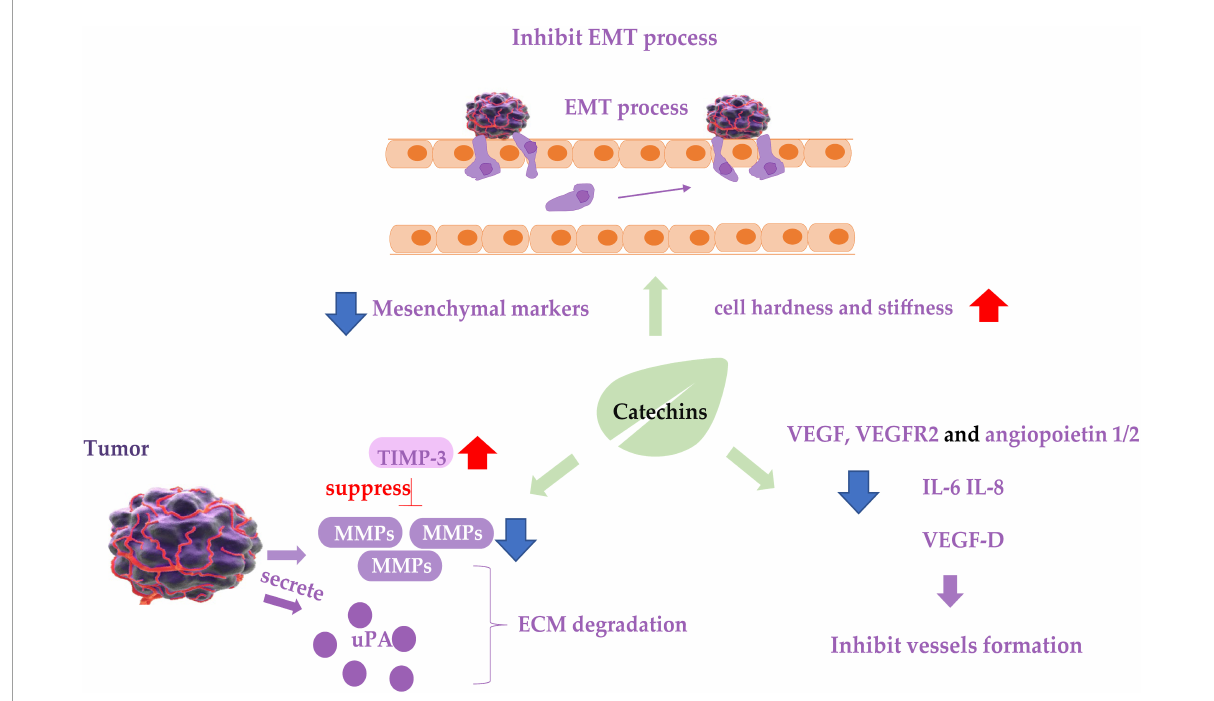
FIGURE2 Diagram of catechins inhibiting cancer cell metastasis. Blue arrows indicate downregulation and red arrows indicate upregulation. EMT, epithelial-mesenchymal transition process; TIMP-3, tissue inhibitor of metalloproteinase-3; MMP, matrix metalloproteinases; ECM, extracellular matrix; uPA, urokinase plasminogen activator; VEGF, vascular endothelial growth